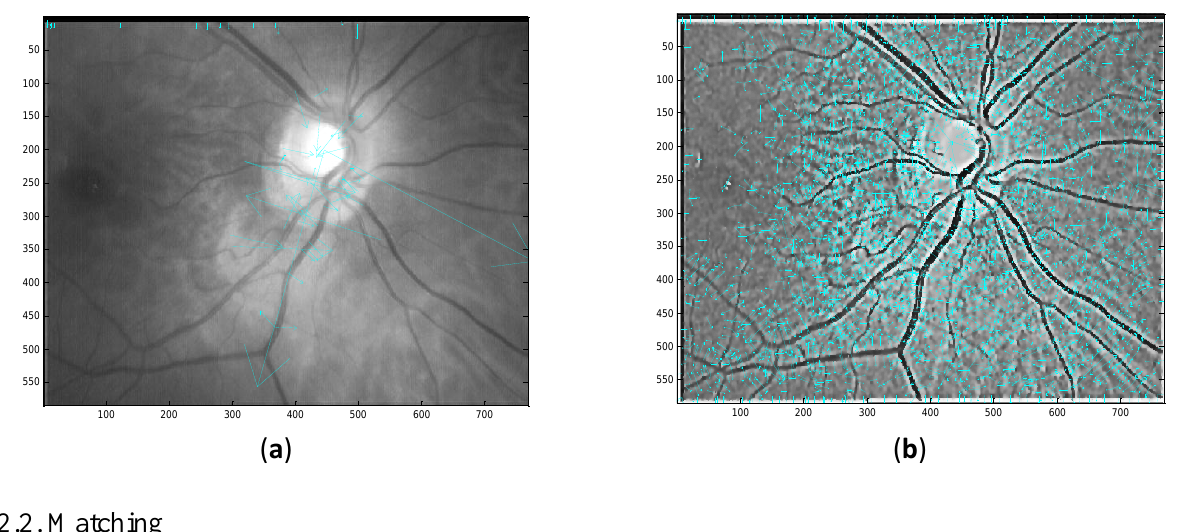
Figure 6. Illustrations of the distributions of keypoints. ( a ) keypoints distribution before enhancement; ( b ) keypoints distribution after enhancement.